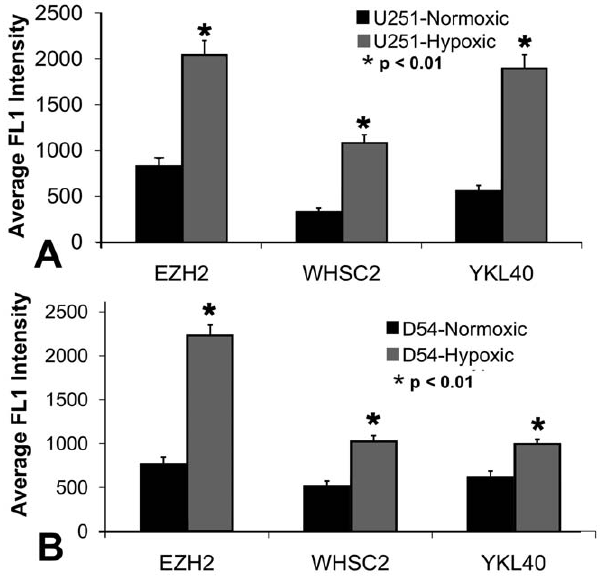
Figure 2. Glioma cells grown under hypoxic conditions express more EZH2, Whsc2 and YKL-40 at the protein level. U251 cells grown under either hypoxic or normoxic conditions for 1 week, were harvested, fixed and stained for the intracellular presence of EZH2, Whsc2 and YKL-40. Panel A displays the mean peak channel intensity of 10,000 U251 cells analyzed for intracellular EZH2, Whsc2 and YKL-40, while Panel B shows the data using the D54 cells. The asterisk indicates P , 0.01